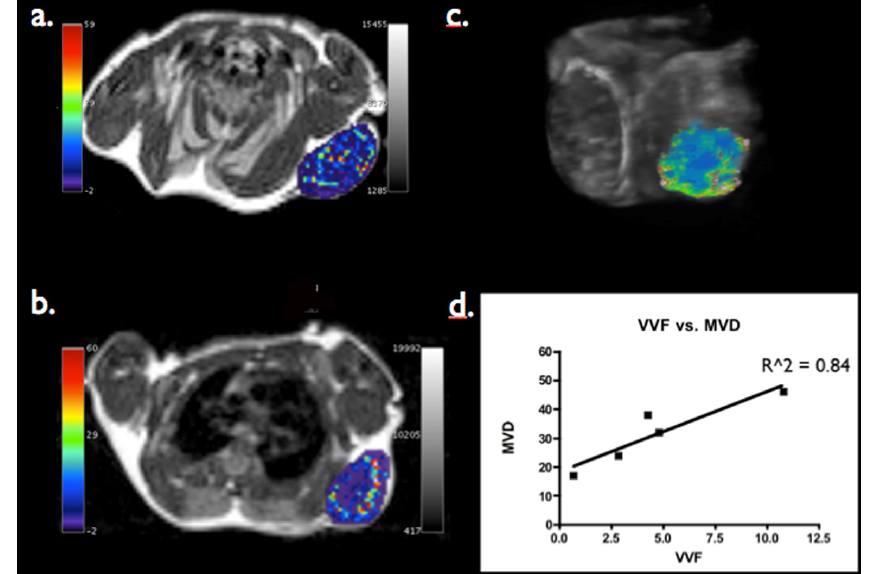
Figure 2. T1-weighted MRI of mice with pseudocolorized VVF maps superimposed over the center of the tumor within the left flank prior to ( a ) and following ( b ) the administration of ShH antibody. Note the heterogeneity of signal intensity and color spread at baseline, with marked decrease in vascularity in the post-treated mouse as compared to pre-baseline. ( c ) 3dimensional VVF map of the mouse tumor in the left flank. ( d ) VVF was quantified in all treated mice and correlated histologically to anti-CD-31 microvessel density. Note the excellent correlation of VVF to MVD. Figure from Guimaraes et al . (unpublished